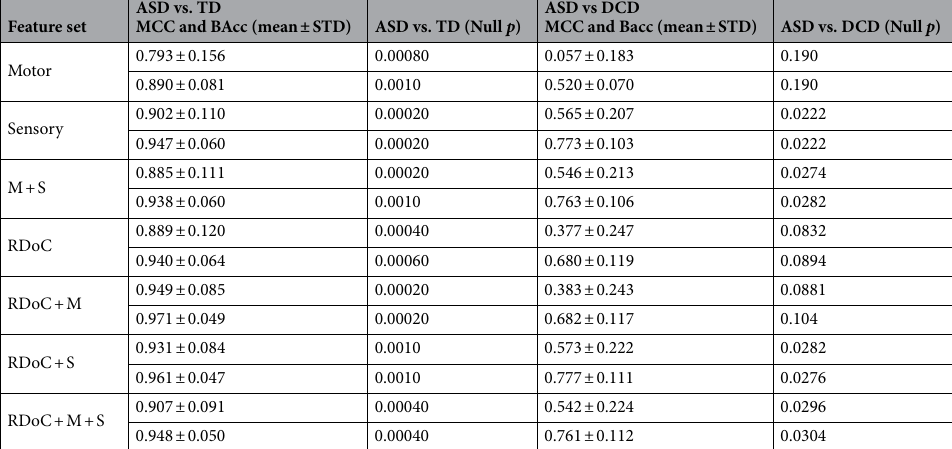
Table 5. Average MCC (top) and BAcc (bottom) performance of each optimized feature set. Mean and standard deviation of MCC and BAcc performance across 2000 cross validation loops, as well as p value calculated against a null distribution reported for both decoders.